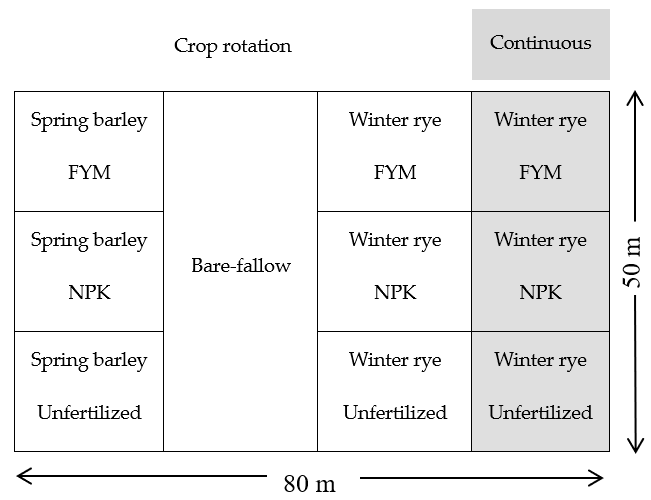
Figure 1. Design of the long-term field experiment in Groß-Enzersdorf (in 2017). FYM = farmyard manure; NPK = mineral fertilizer, Unfertilized = unfertilized control; white sub-plots: bare-fallow, winter rye and spring barley in crop rotation; grey sub-plots: continuous cropping of winter rye.